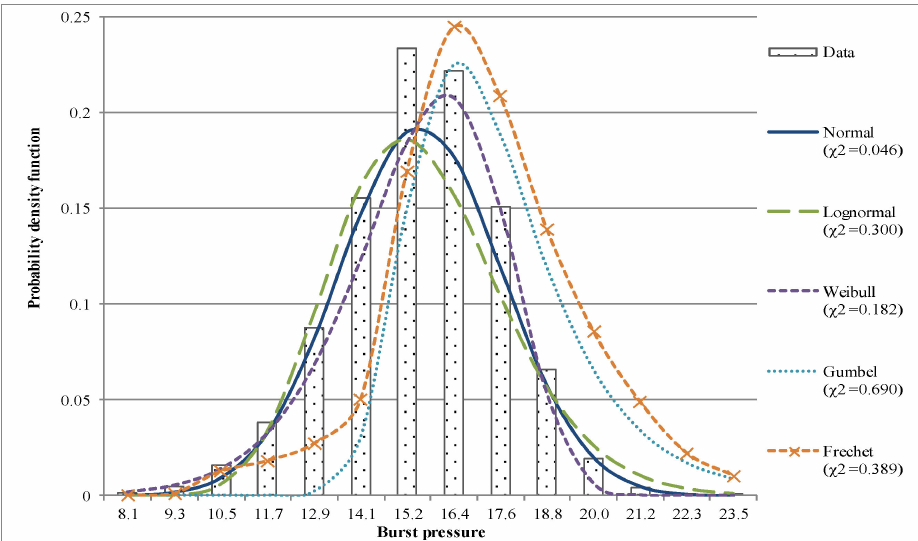
Figure 1. Distribution fitting of and Chi-squared test results for a sample resistance (burst strength) for the top model low-grade